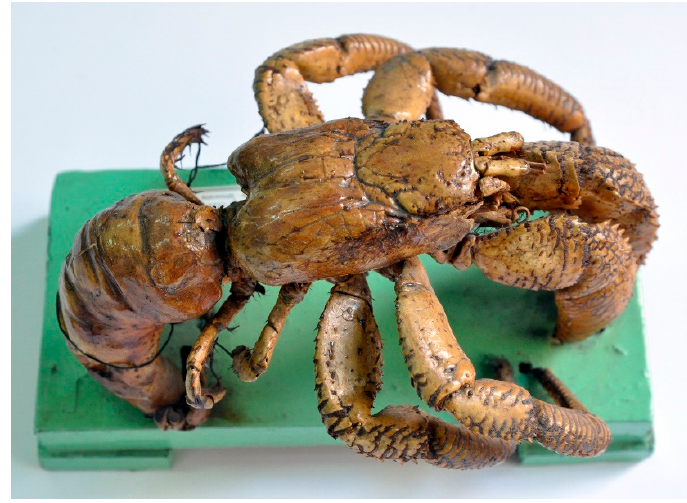
Figure 3. Dardanus arrosor IM359.